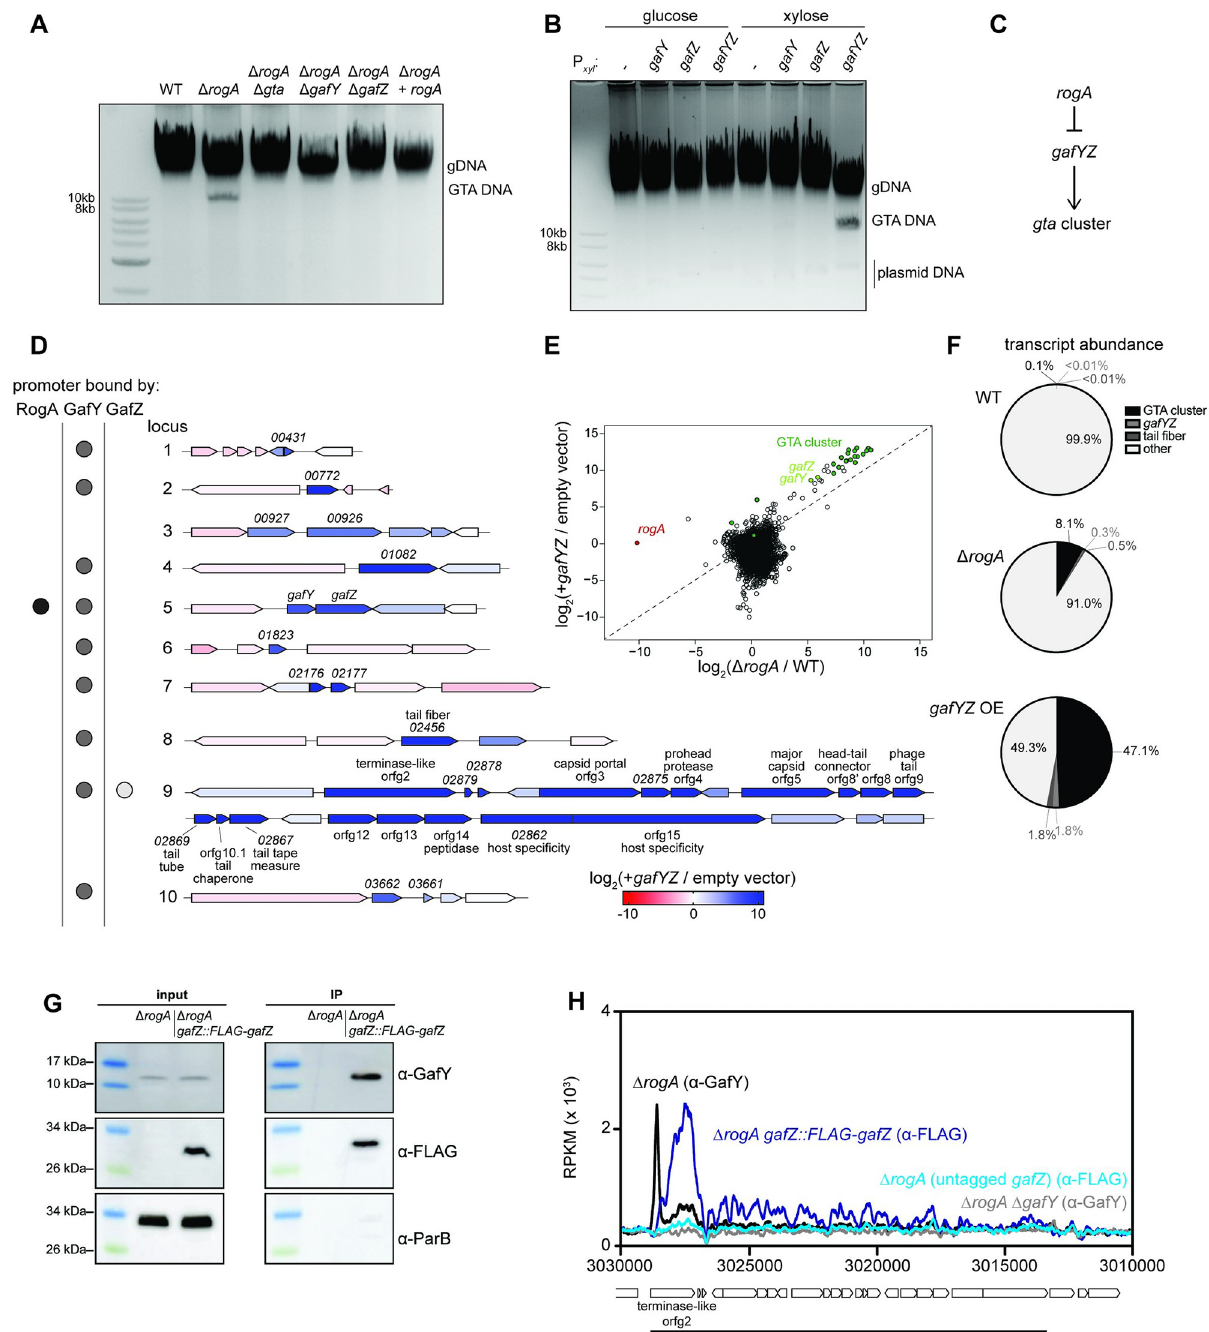
Fig 2. Characterization of the GTA regulatory pathway. (A) Total DNA extraction from different strains grown up to stationary phase. DNA was purified and separated via gel electrophoresis on a 1% agarose gel. (B) Same as A with total DNA extracted from strains bearing a high-copy plasmid with the xylose promoter driving expression of either nothing (empty), gafY alone, gafZ alone, or both gafY and gafZ in their native arrangement. (C) Simple genetic diagram of how the gta gene cluster is hypothesized to be regulated. (D) Transcriptomic analysis comparing gafYZ overexpression to an empty vector control in stationary phase using RNA-seq. The 10 up-regulated loci from the Δ rogA RNA-seq are shown with their corresponding shading for the log 2 fold change of each gene during gafYZ overexpression. Binding of RogA, GafY, and GafZ, as determined by ChIP-seq, are shown for each locus’ promoter by a black, gray, or white dot, respectively. (E) Log 2 fold change of each gene during gafYZ overexpression compared to an empty vector is plotted as a function of the gene’s log 2 fold change in a Δ rogA mutant compared to the wild-type strain. Genes in the GTA cluster are highlighted in dark green, gafY and gafZ in light green, and rogA in red. R 2 of the GTA cluster genes and gafYZ (log 2 transformed) is 0.92. Data are